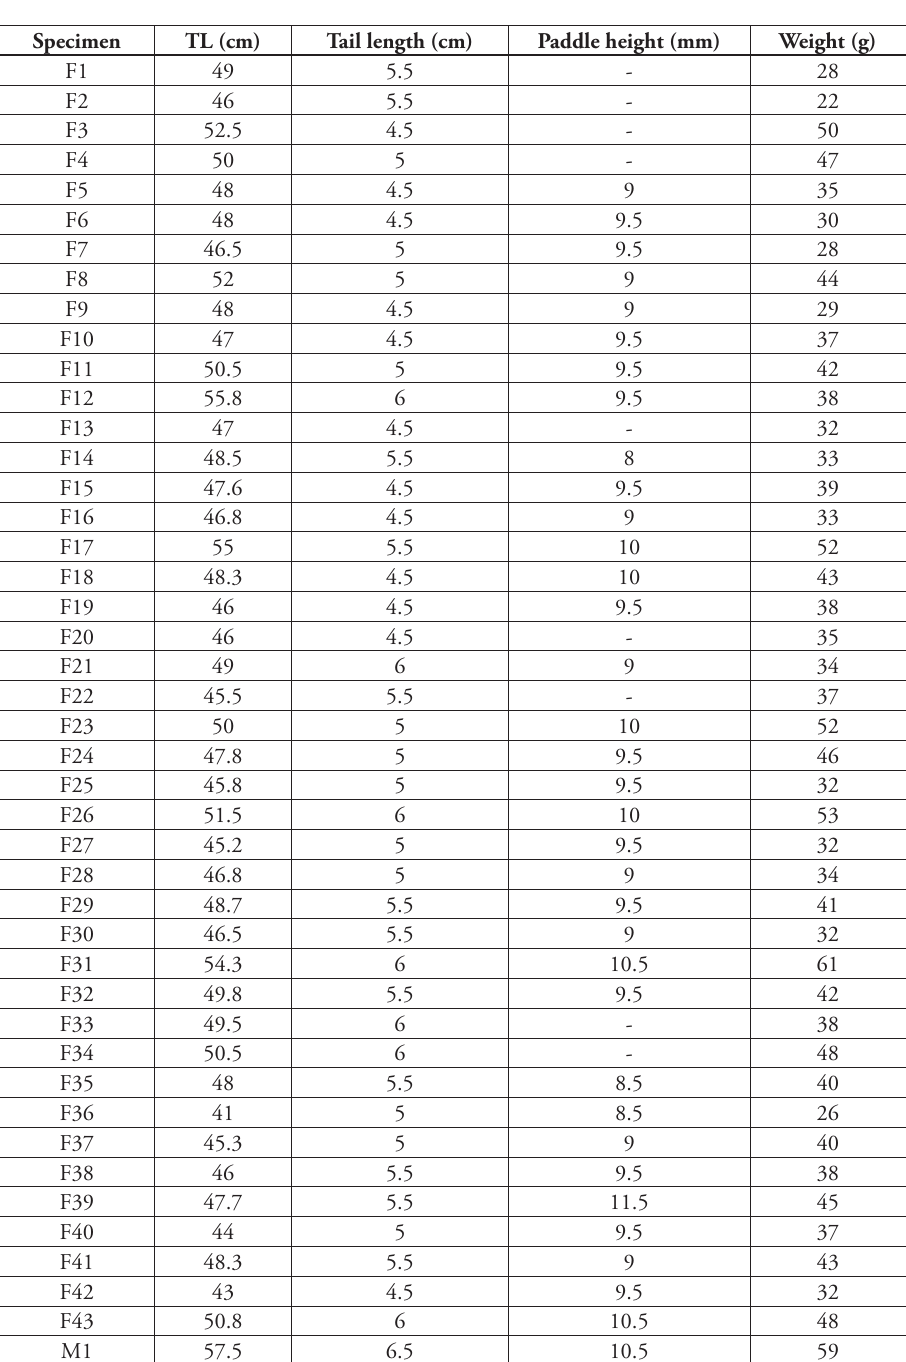
Table 1. Body measurements for 69 individual Hydrophis platurus xanthos from the inner basin of Golfo